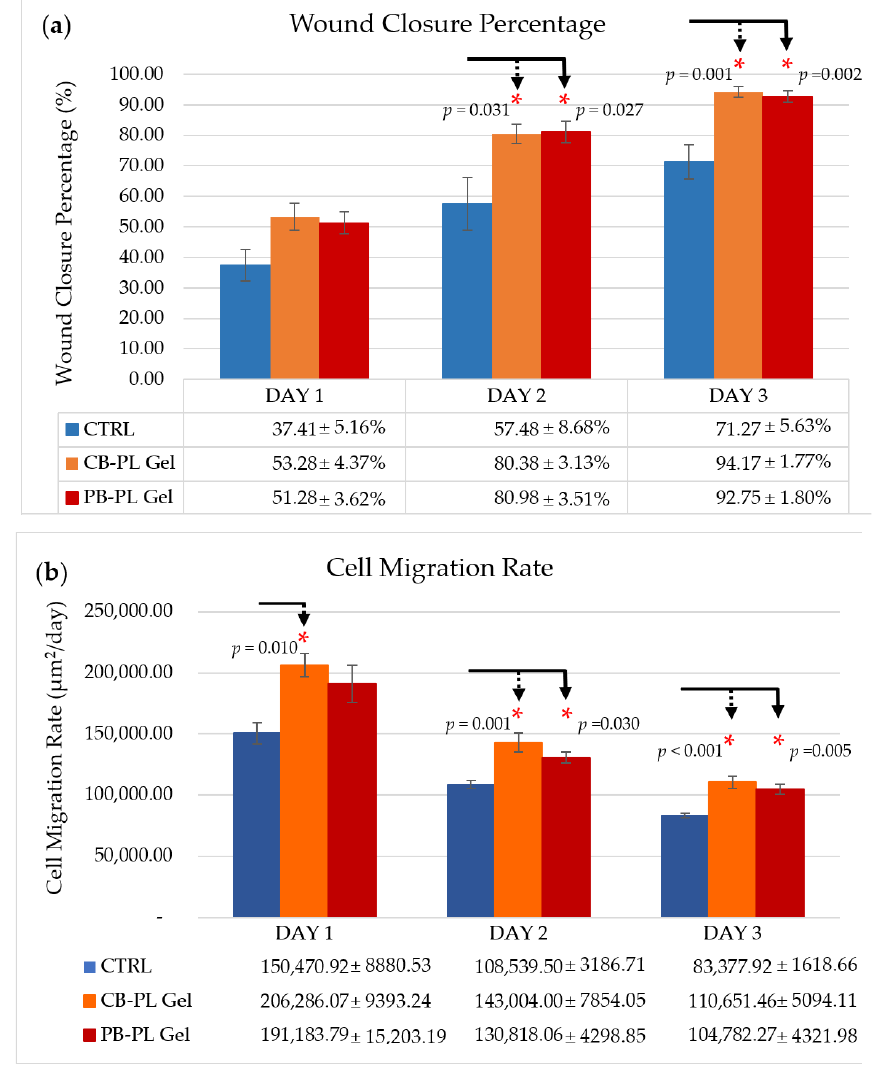
Figure 2. Wound healing effects of CTRL, CB-PL gel, and PB-PL gel on HOMF migration. The wound healing was assessed by measuring the ( a ) wound closure percentage and ( b ) cell migration rate after exposure to PL gels for 1, 2, and 3 days. The results were based on six independent tests ( n = 6) and the means ± SEM were provided. The statistical significance of CB-PL gel and PB-PL gel in comparison to CTRL was indicated by * p < 0.05.